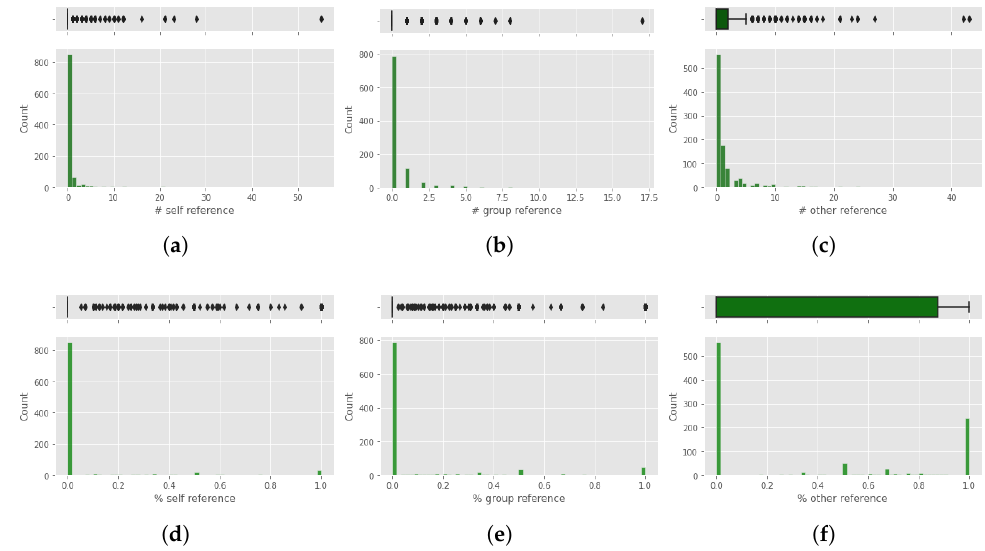
Figure 7. Non-immediacy attributes of fake news items: ( a ) No. of self reference, ( b ) percentage of self reference, ( c ) No. of group references, ( d ) percentage of group reference, ( e ) No. of other references and ( f ) percentage of other references.